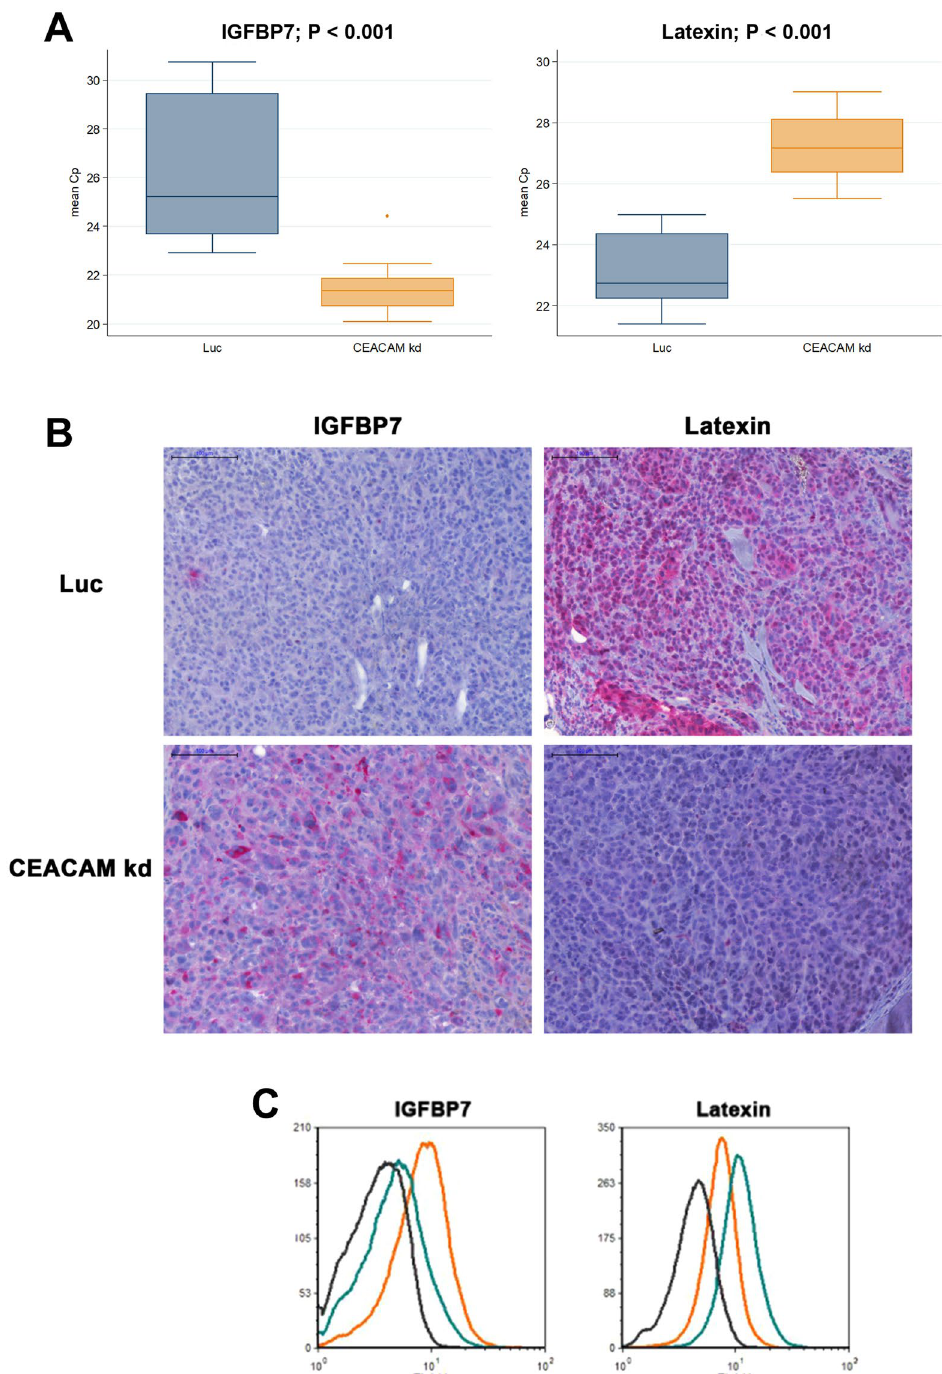
Figure 3. IGFBP7 expression is up- and Latexin expression is downregulated in the xenograft melanoma induced by CEACAM1 kd cells. ( A ) IGFBP7 and Latexin expression are significantly regulated on the transcriptional level as determined by qRT-PCR with template cDNA derived from RNA from MeWo tumors (human melanoma cell line) subcutaneously grown in scid mice. Please note that lower Cp values mean higher levels of expression: IGFBP7 expression is significantly higher in MeWo CEACAM1 kd than in MeWo Luc control tumors whereas latexin expression is significantly lower in the MeWo CEACAM1 kd tumors. Each experiment was performed twice with 5 replicates each time. ( B ) Immunohistochemical staining of paraffin embedded tumor tissue (xenograft MeWo tumors in scid mice) for IGFBP7 and latexin demonstrated respective up- and downregulation of these two proteins. Little to no IGFBP7 (in red) could be shown in the MeWo Luc tumors (upper left panel) whereas high IGFBP7 was detected in the MeWo CEACAM1 kd tumors (lower left panel). Vice versa, high latexin expression could be detected in the MeWo Luc tumors (upper right panel) and little to no latexin expression in the CEACAM1 kd tumors (lower right panel). ( C ) IGFBP7 and